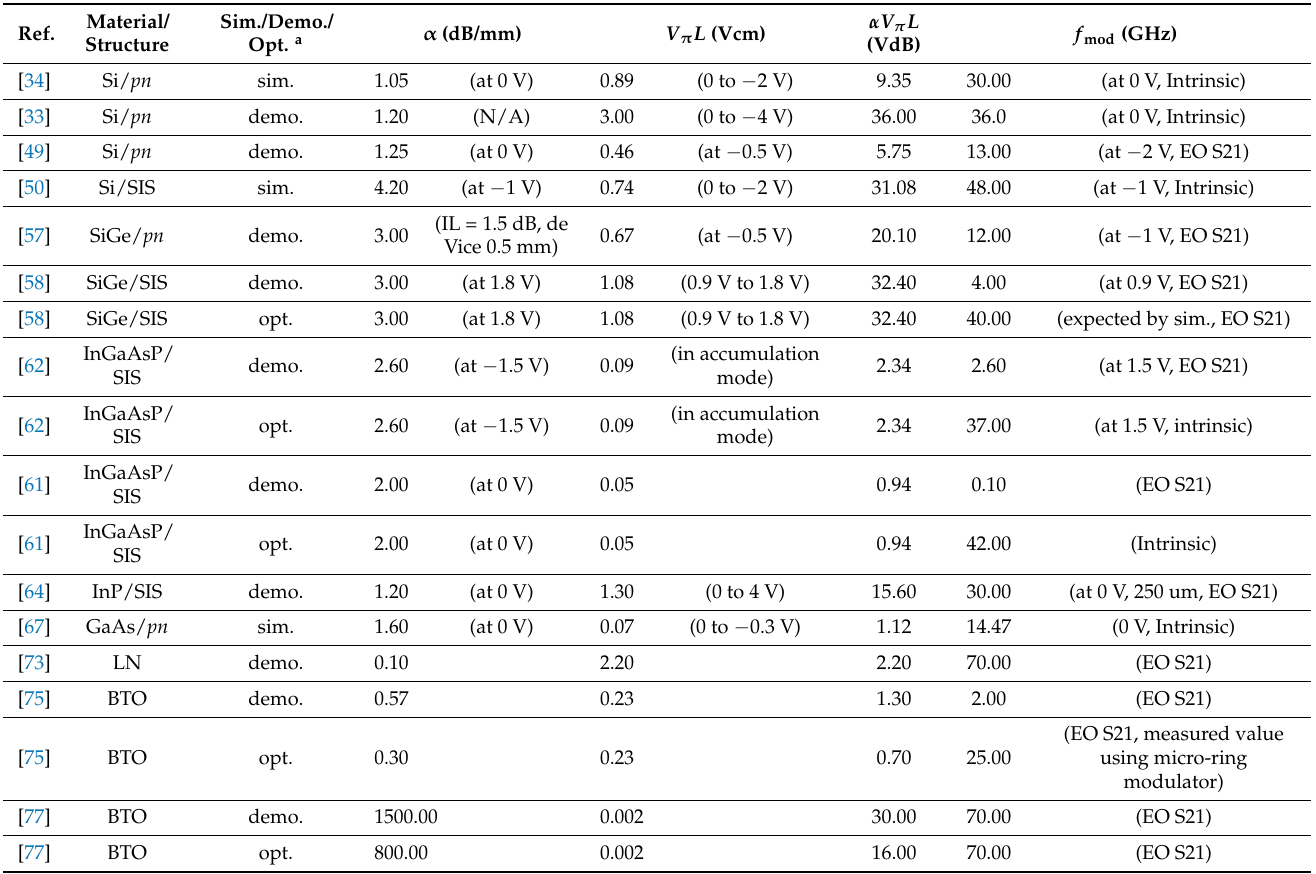
Table 1. Performance comparison of optical phase shifters for modulators based on loss, V π L , the product of them, and 3dB bandwidth of intrinsic RC delay or electrooptical S21